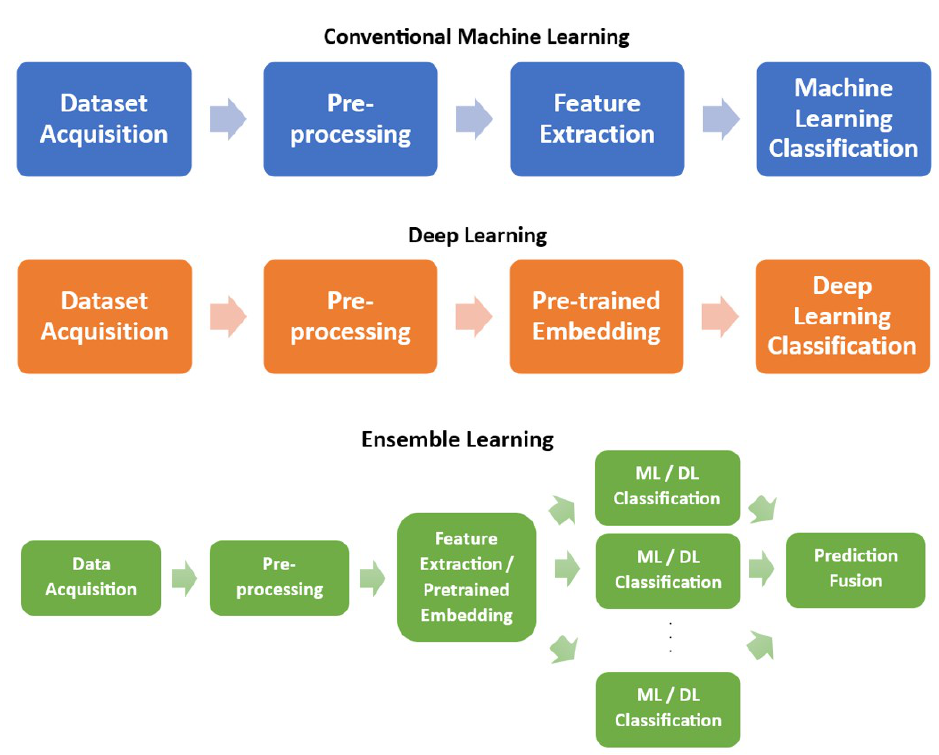
Figure 2. Flow charts of the sentiment analysis process using conventional machine learning, deep learning, and ensemble learning